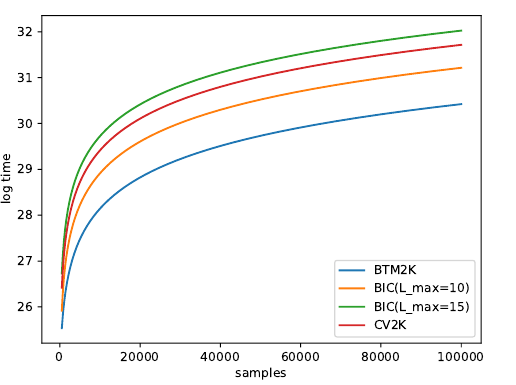
Figure 3. Log running time estimation for Btm2K and BIC with a maximum of 10–15 clusters and CV2K as a function of the number of samples. Here, K max = 10 was used. For CV2K and Btm2K , L max = 15 was